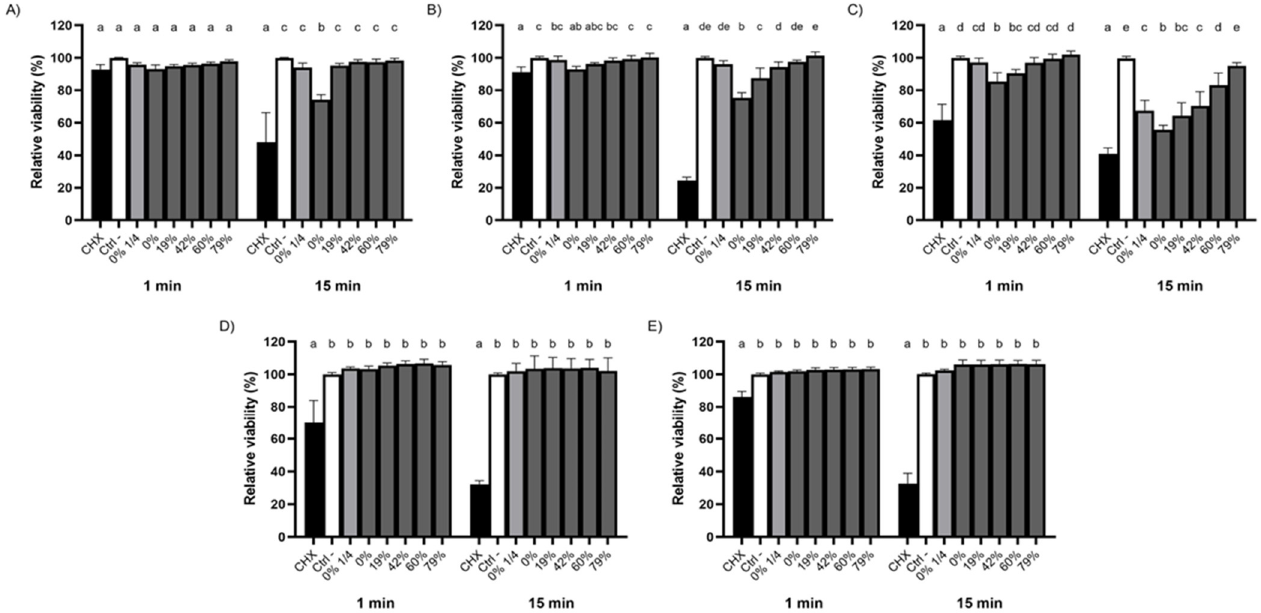
Figure 2. Effect of the deacidification rate (0, 19, 42, 60, and 79%) of cranberry juice on the killing of biofilm-embedded ( A ) S. mutans , ( B ) S. sobrinus , ( C ) S. gordonii , ( D ) S. oralis , and ( E ) S. salivarius following 1- and 15-min exposures. A ¼ dilution of raw CJ was also included. Cell viability was assessed using FilmTracer LIVE/DEAD Biofilm Viability kit. A 100% value was attributed to the negative control (PBS). Results are expressed as means ± SD of triplicate assays from three independent experiments. Columns with different letters are significantly different from one another (Two-way ANOVA, Bonferroni test, p < 0.01). CHX: Chlorhexidine 0.12%. Ctrl: PBS.